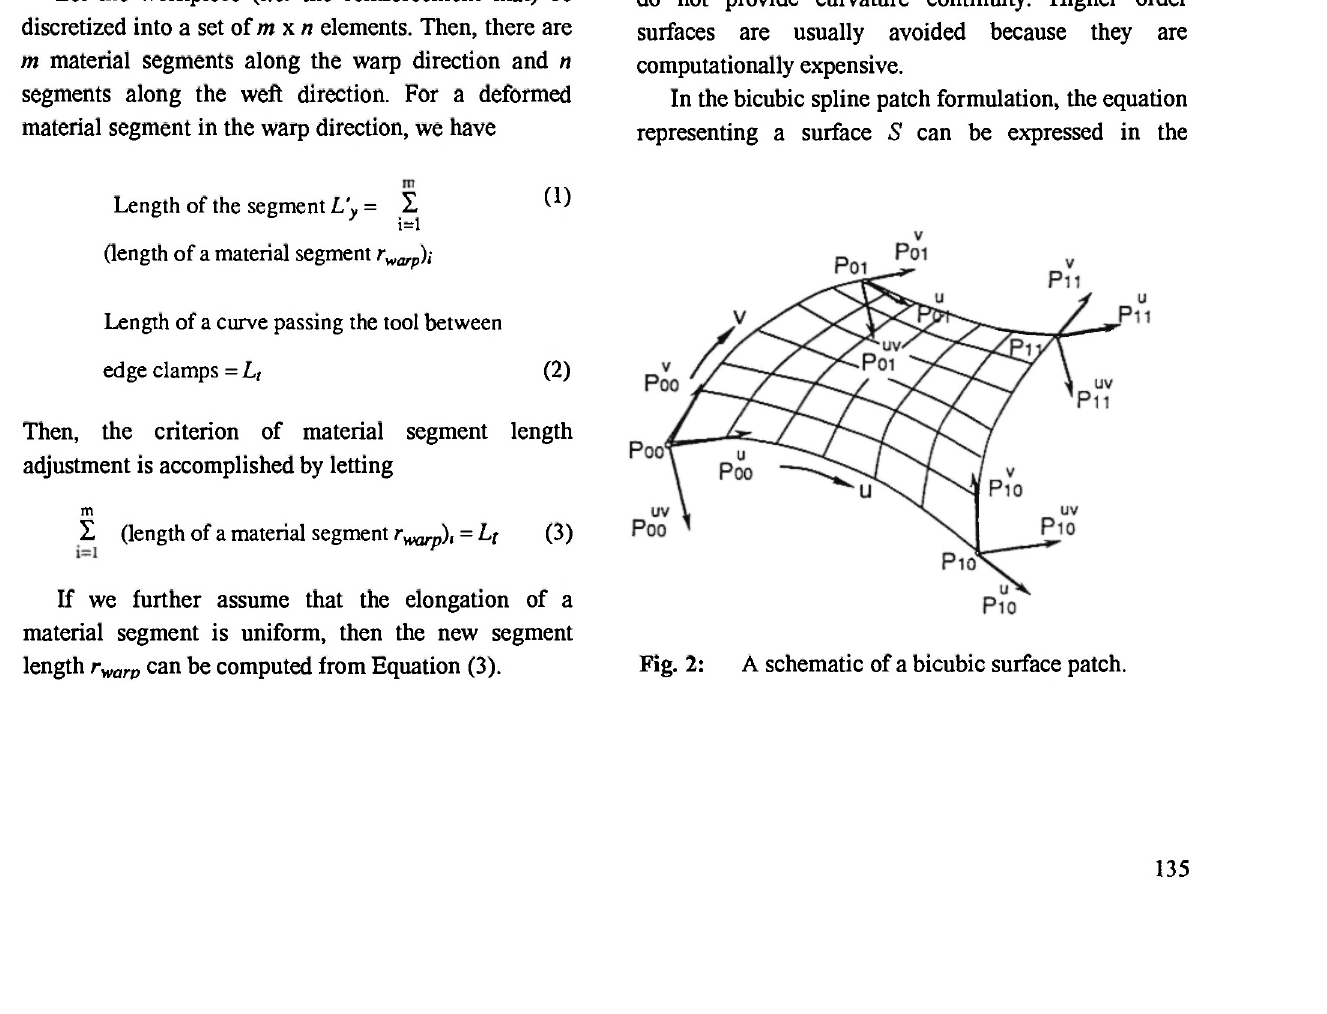
Fig. 2: A schematic of a bicubic surface